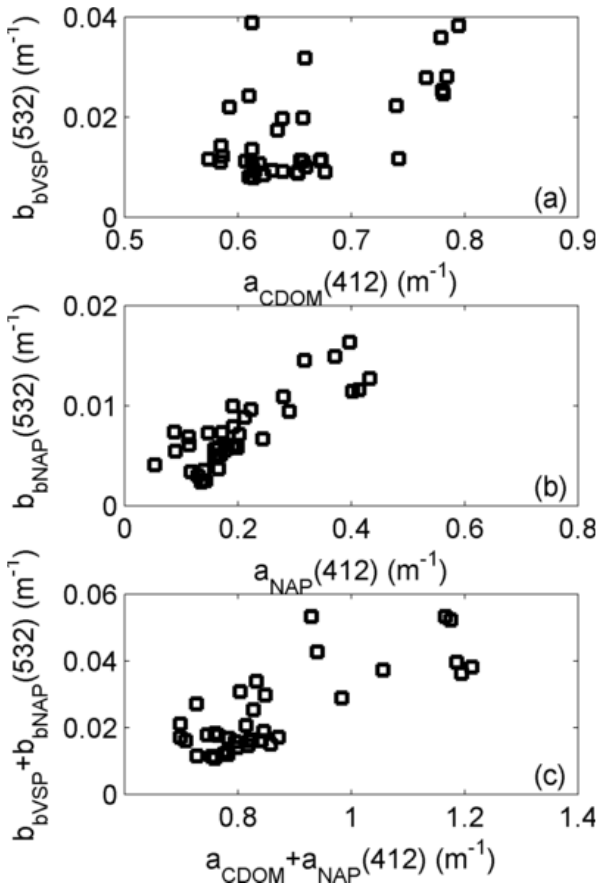
Fig. 8. Intercomparisons of measured absorption and estimated backscattering coefficients for CDOM and NAP. (a) a CDOM (412) measured using the ac-9 with a 0.2-µm filter vs. b bVSP (532) esti- mated for the VSP group from the VSF-inversion. (b) a NAP (412) estimated from the ac-s absorption inversion vs. b bNAP (532) esti- mated for the NAP group from the VSF-inversion. (c) absorption coefficient for the NAM population, a CDOM ( 412 ) + a NAP (412) vs. the backscattering scattering coefficient for the NAM population, b bVSP ( 532 ) + b bNAP ( 532 )